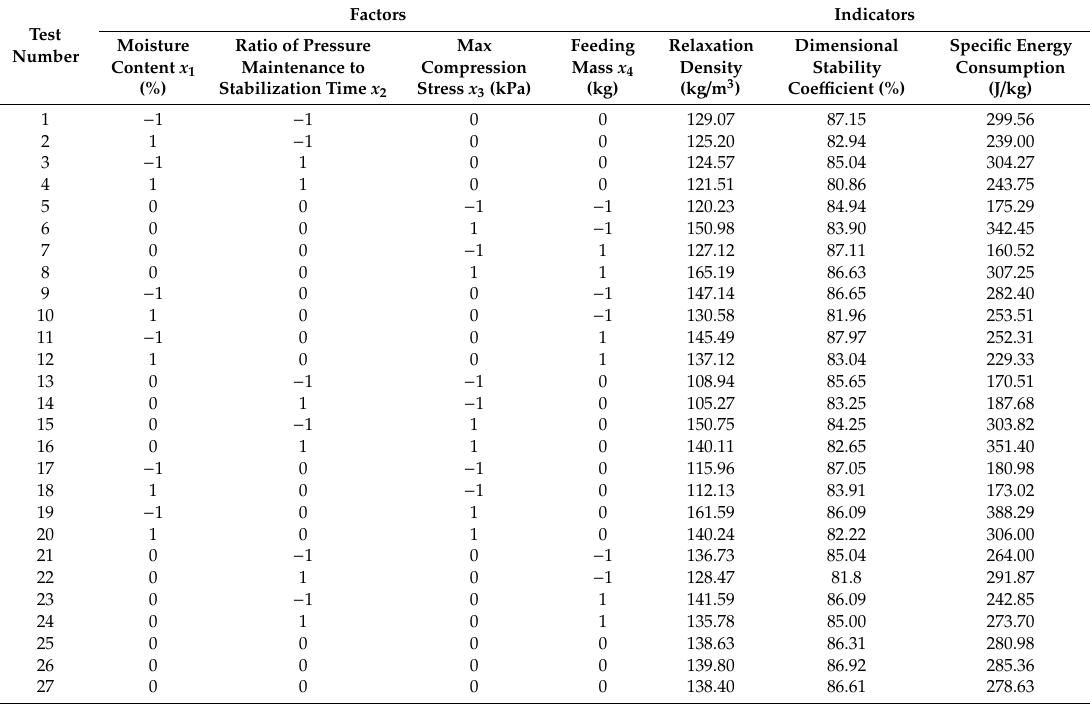
Table 4. Mean values of relaxation density, dimensional stability coe ffi cient and specific energy consumption based on the Box–Behnken design.